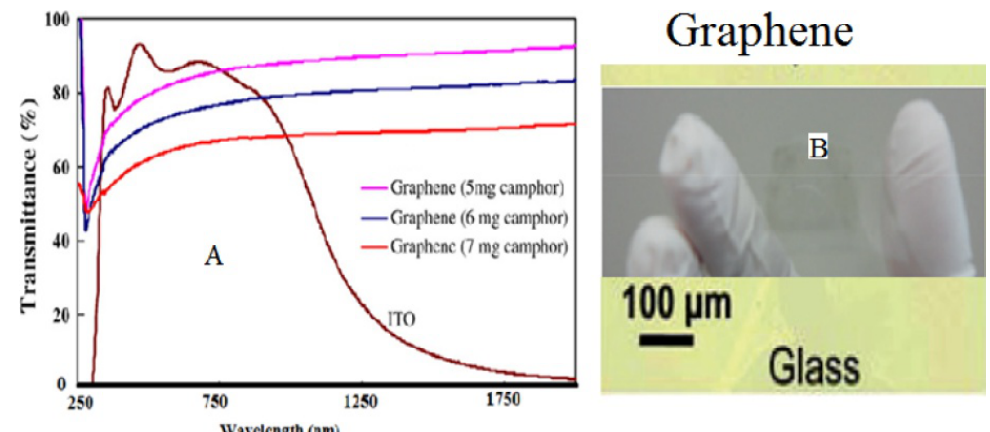
Fig. 3. (a) Transmittance by the large area Graphene sheets synthesized using different amounts of cam- phor and transferred on glass. ( © 2010 Elsevier, Courtesy: Kalita et al., Materials Letters 64, 2010, 2180– 2183, Ref. [53]) ; (b) A photograph of monolayer graphene film transferred to PET substrates. ( ©